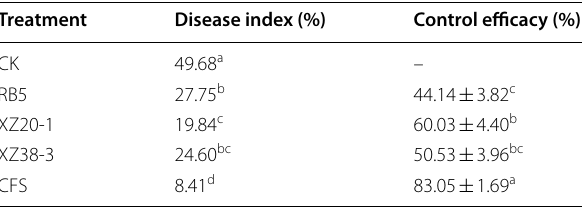
Table 3 Control efficacy of fermentation supernatants on wheat sheath blight